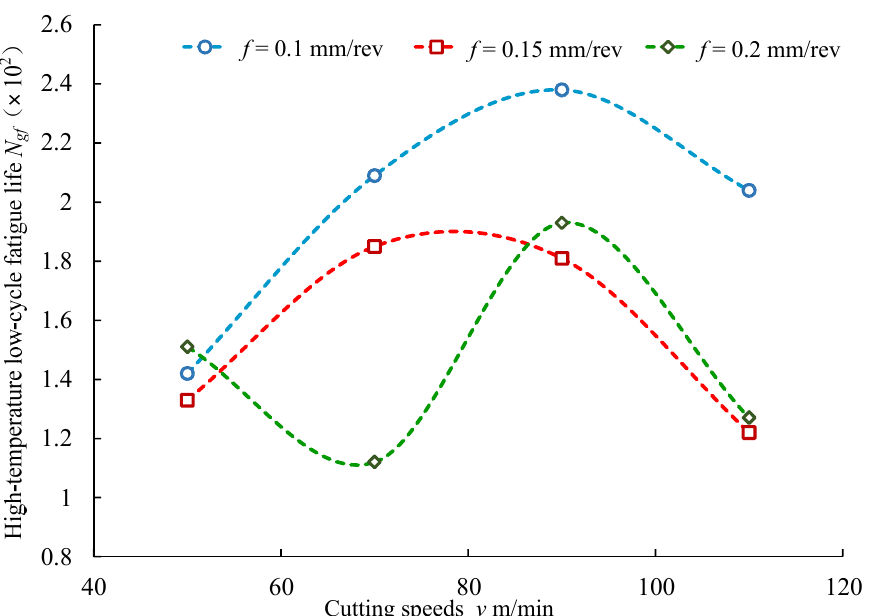
Figure 14. Effects of cutting speeds on high-temperature low-cycle fatigue life. The effects of feed rates on high-temperature low-cycle fatigue life are shown in Figure 15. At lower cutting speeds, v = 50 m/min and v = 70 m/min, the high-temperature low-cycle fatigue life first increased and then decreased with the increase in feed rates from f = 0.10 mm/rev to f = 0.20 mm/rev. At higher cutting speeds, v = 90 m/min and v = 110 m/min, the high-temperature low-cycle fatigue life decreased with the increase in feed rates from f = 0.10 mm/rev to f = 0.20 mm/rev.